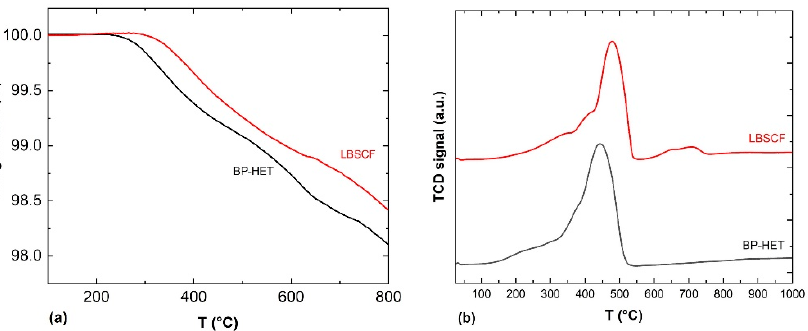
Table 3. Summary of TGA experiments per gram of powder.